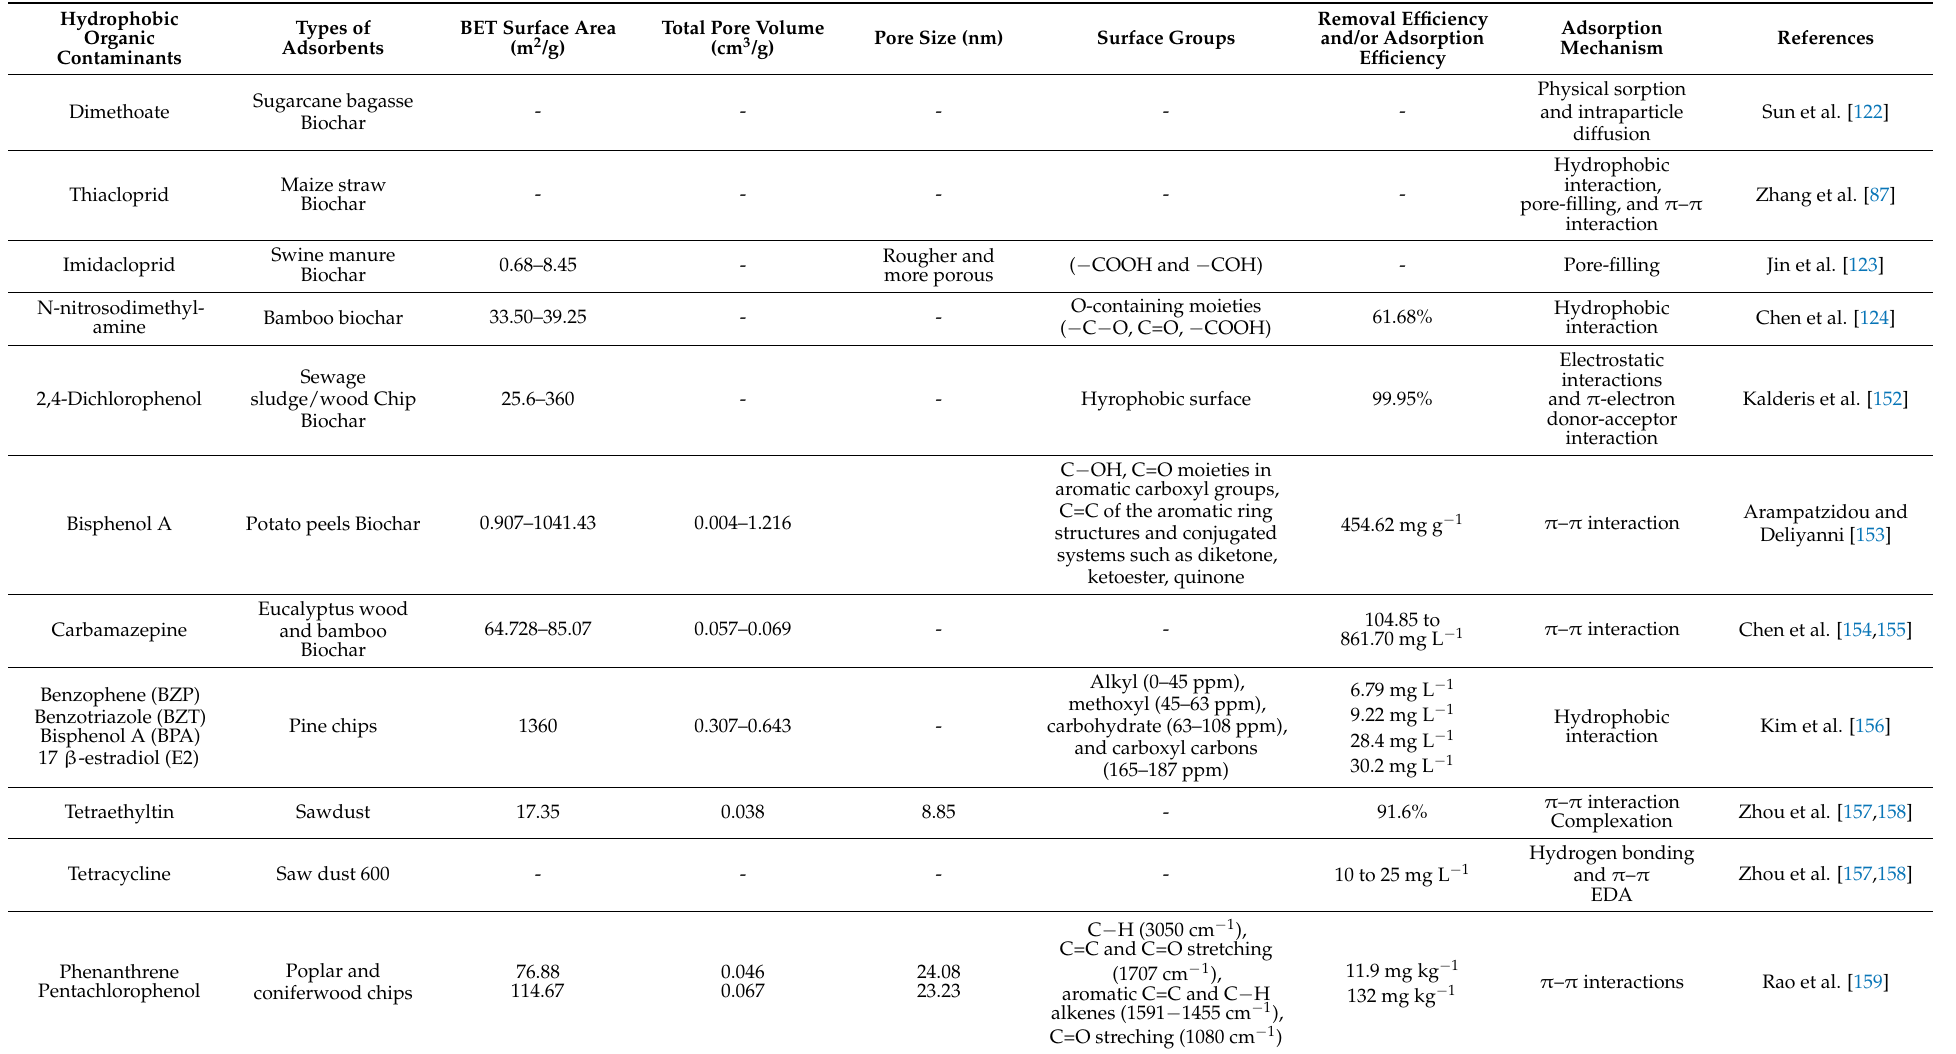
Table 1. Details of the adsorption of HOCs on different adsorbents, their characterization, and removal